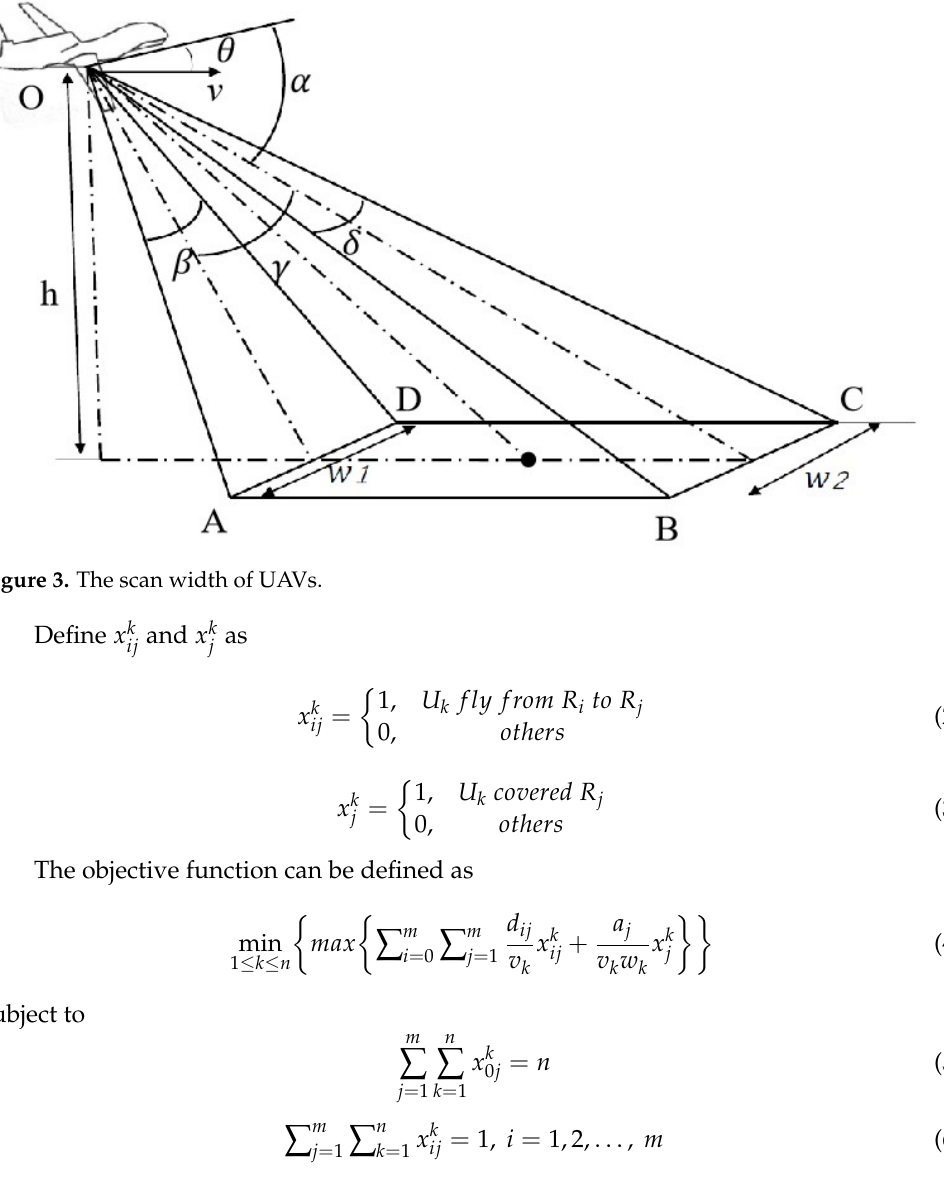
4 of 16 Figure 2. The problem description of multi-regional CPP for multiple UAVs.